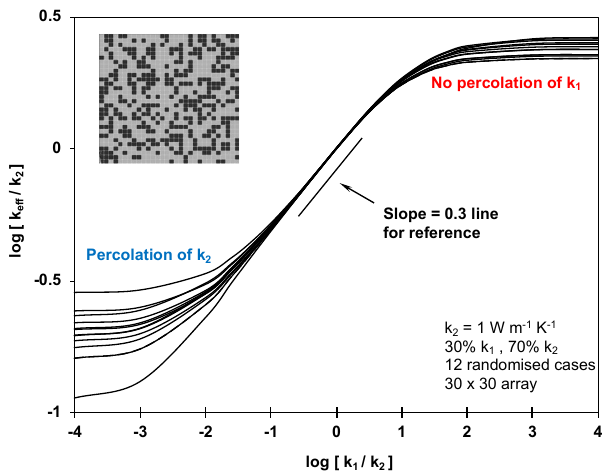
Figure 5. Log-log plot of the equivalent conductivity as a function of k 1 / k 2 for the 30% k 1 –70% k 2 system ( α 1 = 0.3). Phase k 1 (black) is variable and k 2 (grey) is constant.